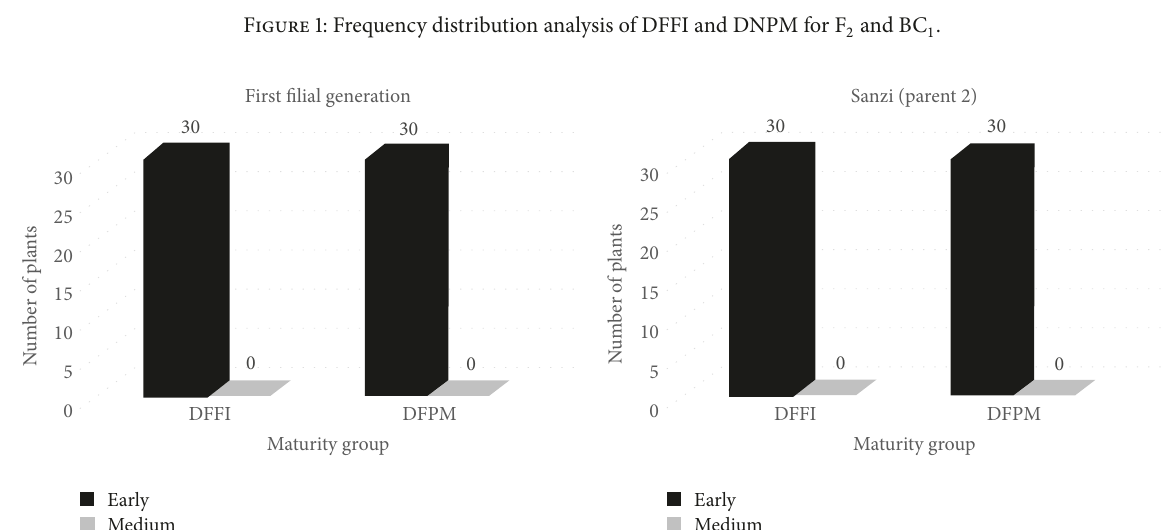
Figure 2: Frequency distribution analysis of DFFI and DNPM for F 1 and